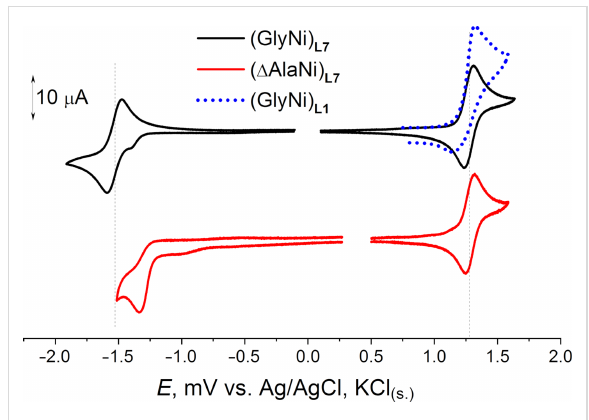
Figure 4: The CV curves observed for ( GlyNi ) L7 and ( Δ AlaNi ) L7 in the anodic and cathodic regions (Pt, CH 3 CN, 0.1 M Bu 4 NBF 4 , 100 mV/s, vs Ag/AgCl/KCl (sat.) ). Oxidation of ( GlyNi ) L1 is given for comparison.